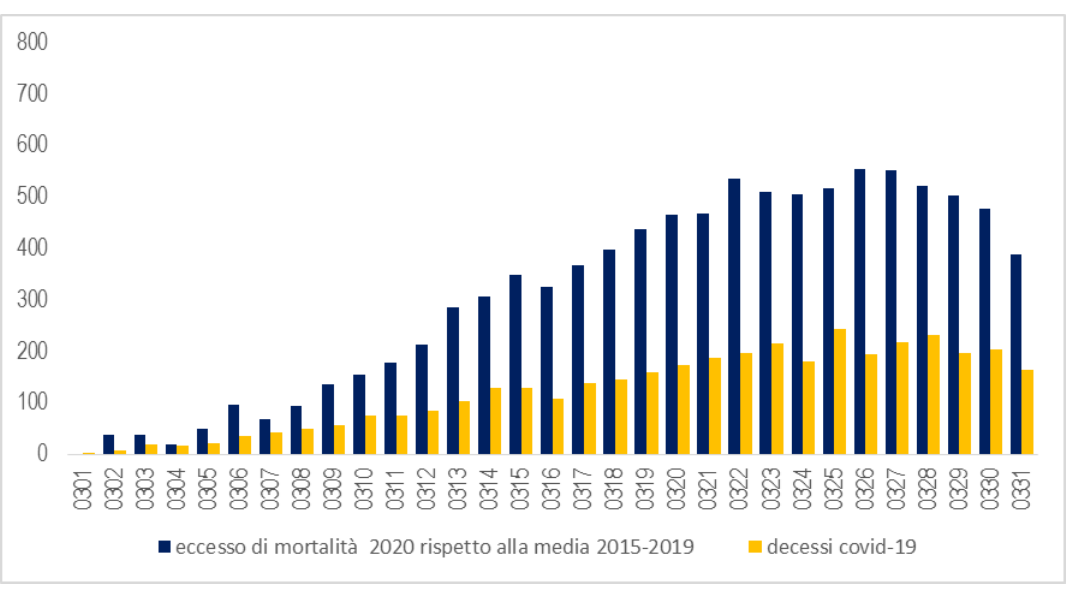
Figura 7. Andamento giornaliero nel mese di marzo dell'eccesso di mortalità femminile registrato nel 2020 rispetto alla media degli anni 2015-2019 e dei decessi Covid-19 (a) . Valori assoluti dei decessi. Province con alta diffusione